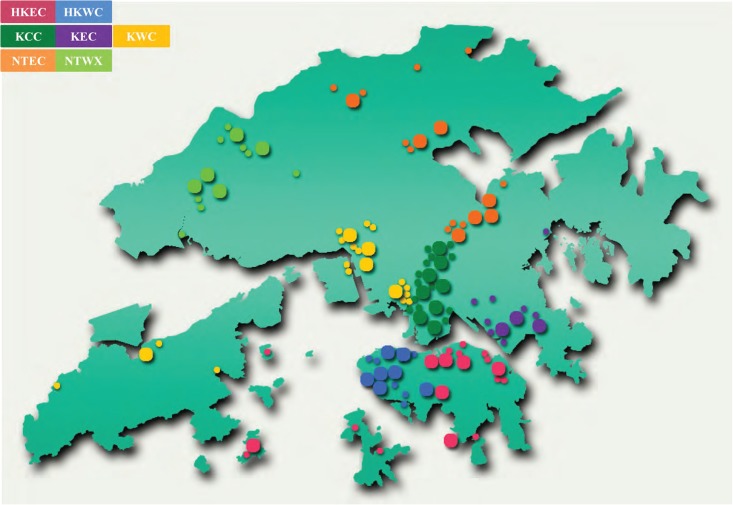
Distribution of clusters and hospitals.